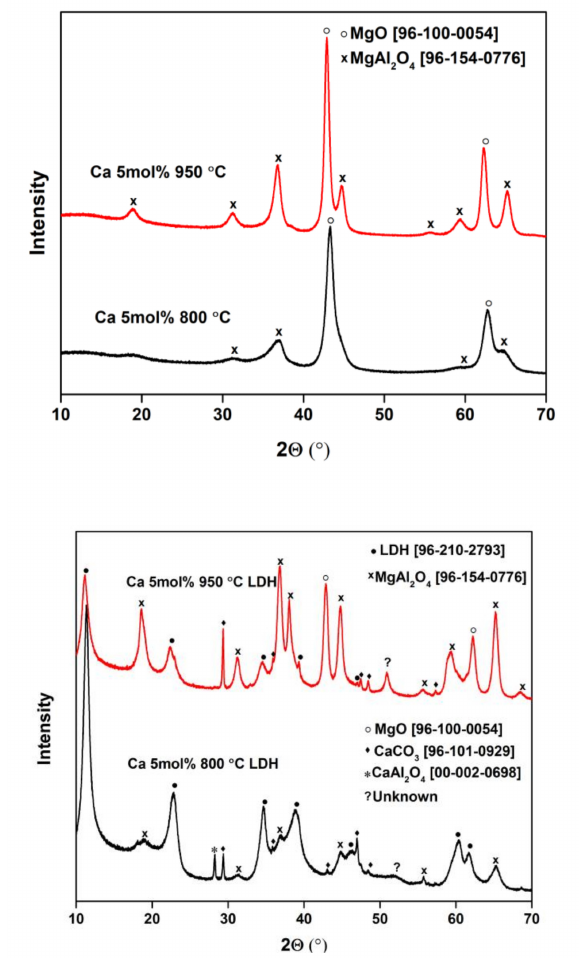
Figure 3. XRD patterns of mixed metal oxides (MMO) obtained by heating the Mg 1.95 Ca 0.05 / Al 1 precursor gels at 800 ◦ C and 950 ◦ C ( top ) and reconstructed Mg 1.95 Ca 0.05 / Al 1 LDHs ( bottom